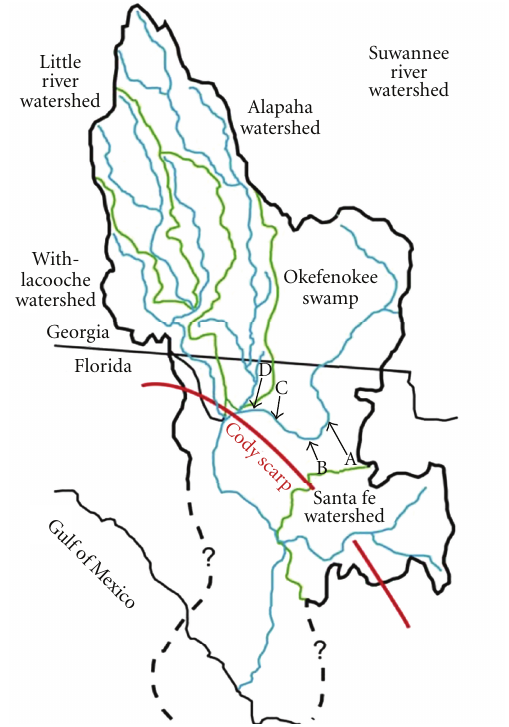
Figure 1: Sampling sites for the Suwannee River. The location of sites on the Suwannee River is shown in relationship to the Suwannee River watershed. Primary sampling locations (arrows) included four sites on the Suwannee River from (A) Big Shoals State Park, (B) White Springs State Park, (C) Spirit of the Suwannee Campground, and (D) Boys Ranch.